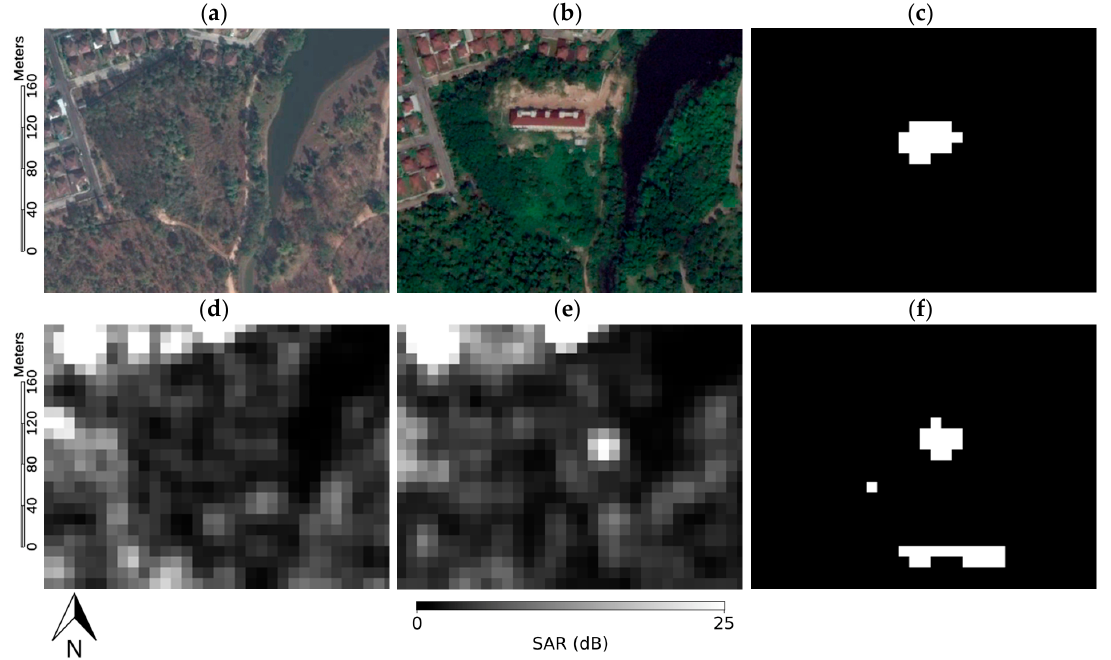
Figure 14. Detection results of the first area in Chiang Mai at 18 ◦ 51’23.49”N 98 ◦ 57’17.90”E. The size of each image is 0.32 × 0.23 km. ( a ) Time 1 optical data; ( b ) Time 2 optical data; ( c ) result of CORN; ( d ) Time 1 SAR data ‘Copernicus Sentinel data [2015]’; ( e ) Time 2 SAR data ‘Copernicus Sentinel data [2017]’; ( f ) result of U-net.